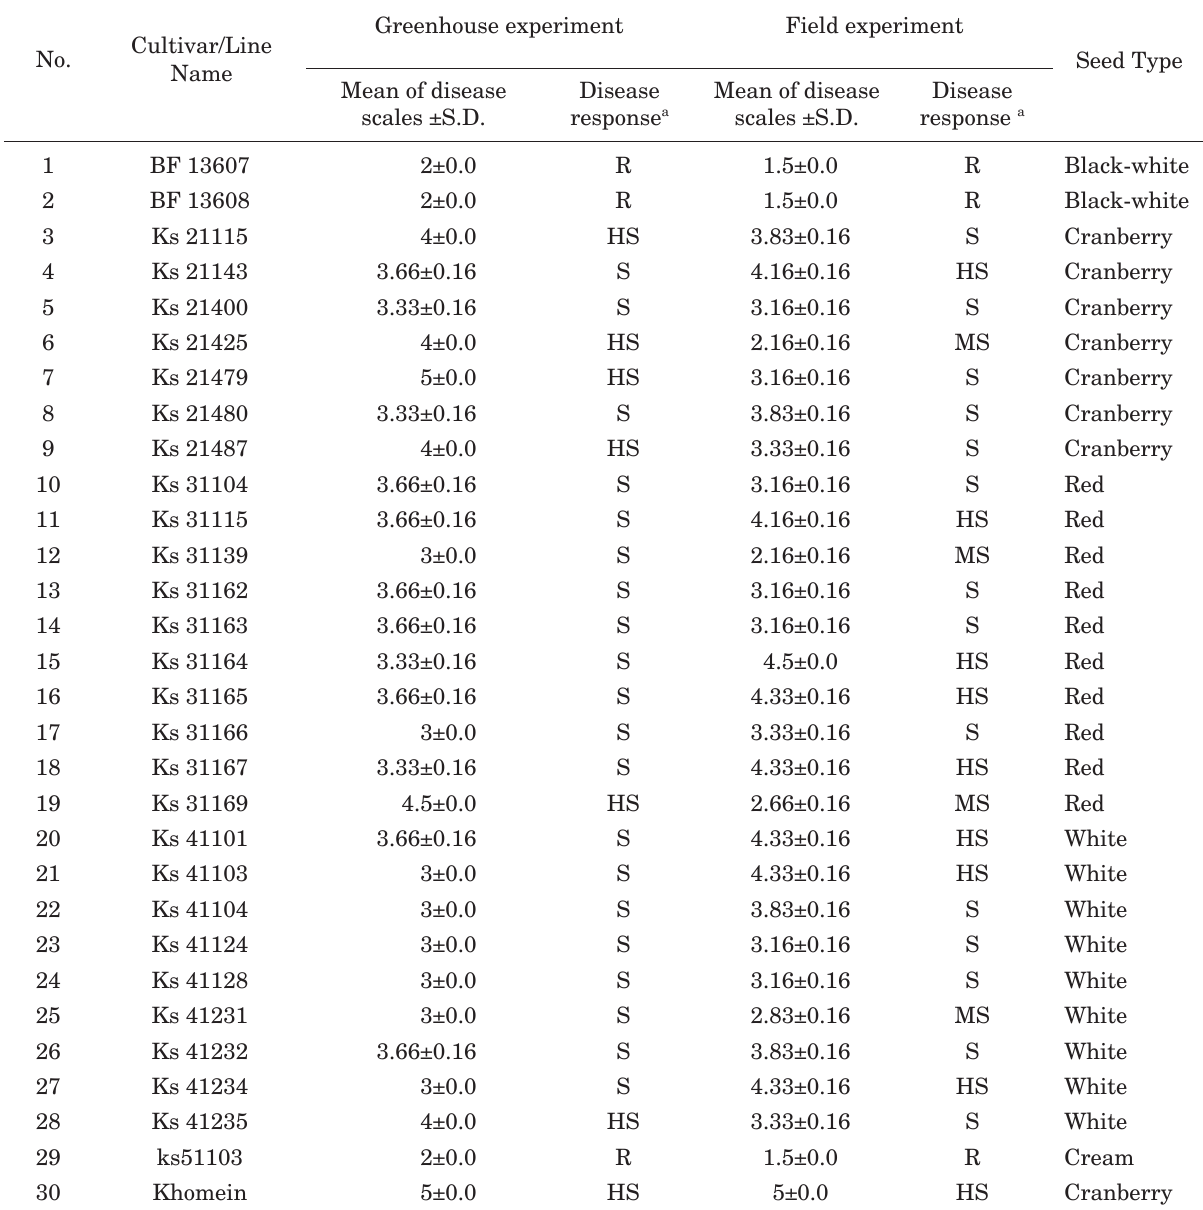
Table 1. List of cultivar/lines used in both greenhouse and field experiments and disease response as mean of disease scales ±S.D. of diseased leaf area (DLA) and of number of spots on the